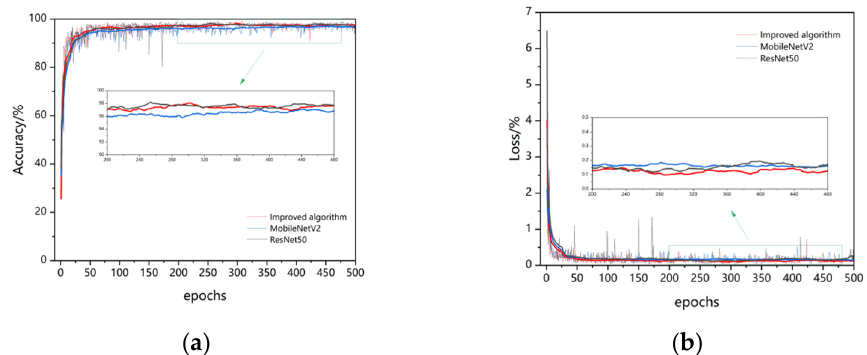
Figure 9. The training curve of each model on the self-built dataset. ( a ) is the recognition accuracy curve. ( b ) is the loss value curve.